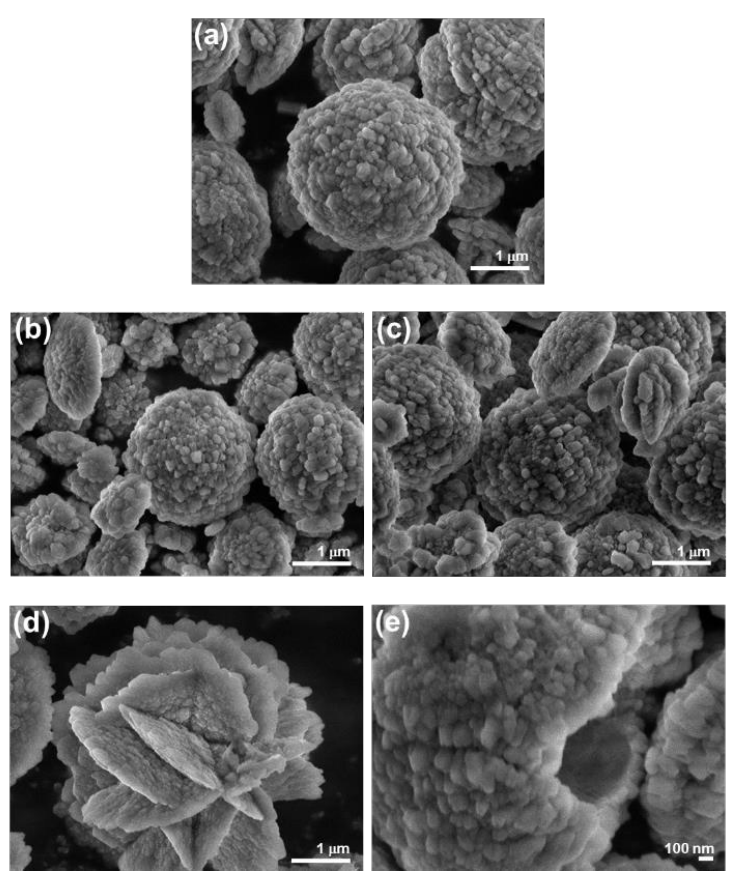
Figure 9. SEM micrographs of vaterite precipitated after 10 min of aging time in the ( a ) absence (CS) and presence of different liposomes: EPC ( b ), DMPC ( c ), and DMPS ( d , e ). presence of different liposomes: EPC ( b ), DMPC ( c ), and DMPS ( d , e ). c i (Ca) = c i (CO 3 ) = 20 mmol dm − 3 ; c i (Ca) = c i (CO 3 ) = 20 mmol dm – 3 ; γ (lipid) = 25.0 ppm; pH i = 8.15; ϑ /°C = 25 ± 0.1. γ (lipid) = 25.0 ppm; pH i = 8.15; ϑ / ◦ C = 25 ±